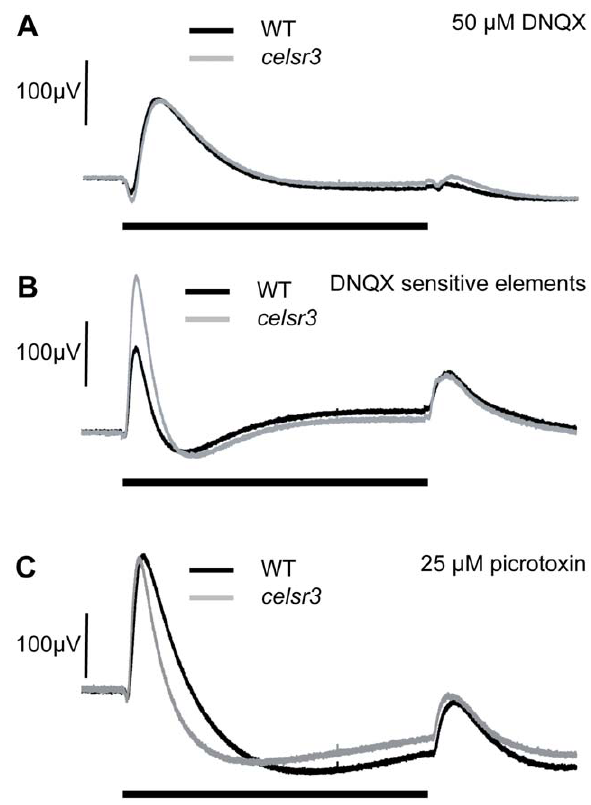
Figure 6. ERGs at 6 dpf in the presence of drugs suggest alterations in GABAergic signaling. A) In 50 m M DNQX, which isolates the ON–bipolar cells, WT and celsr3 mutant eyes have a similar response suggesting that ON-bipolar cells are normal (see Results), and it is ionotropic glutamate responses that are defective. B) The DNQX sensitive curve is obtained by subtracting the DNQX-treated waveform from the untreated response [23]. The isolated DNQX sensitive b-wave element is called b1. The b1 element is larger in celsr3 mutants. C) The WT and celsr3 mutant response is similar in 25 m M picrotoxin, a GABA A/C inhibitor, suggesting that changes to GABA signaling are causing the increase in the celsr3 mutant b1-wave. Black bar indicates 3 sec. light pulse. Graphs are the average of at least 6